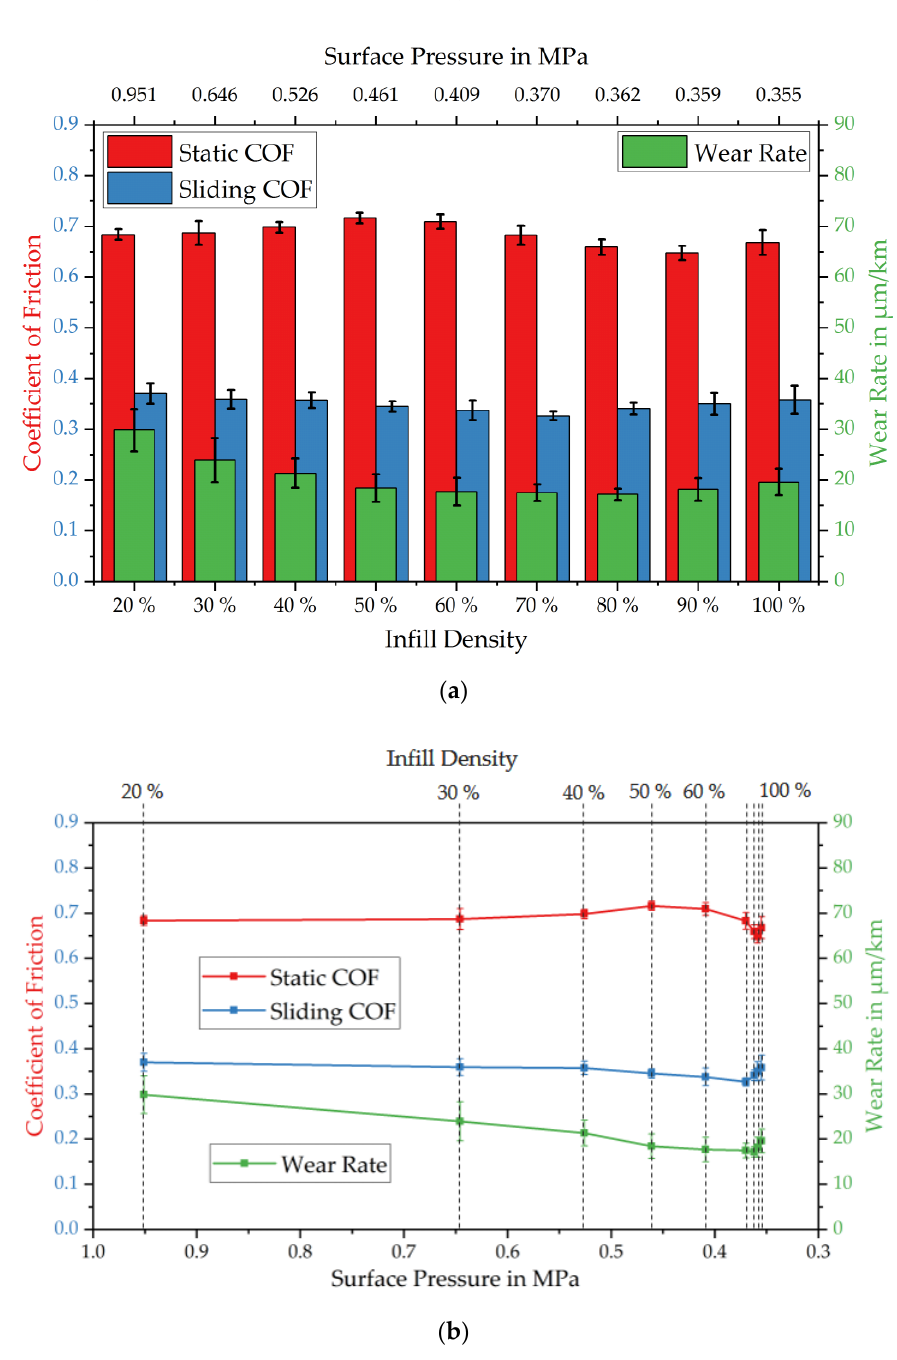
Figure 8. Coefficients of static and sliding friction and wear rate resulting from the variation of infill densities from 20% to 100% respectively for the surface pressures from 0.951 to 0.355 MPa. Scaled according to the equidistant steps of infill density ( a ) and the equivalent surface pressure ( b